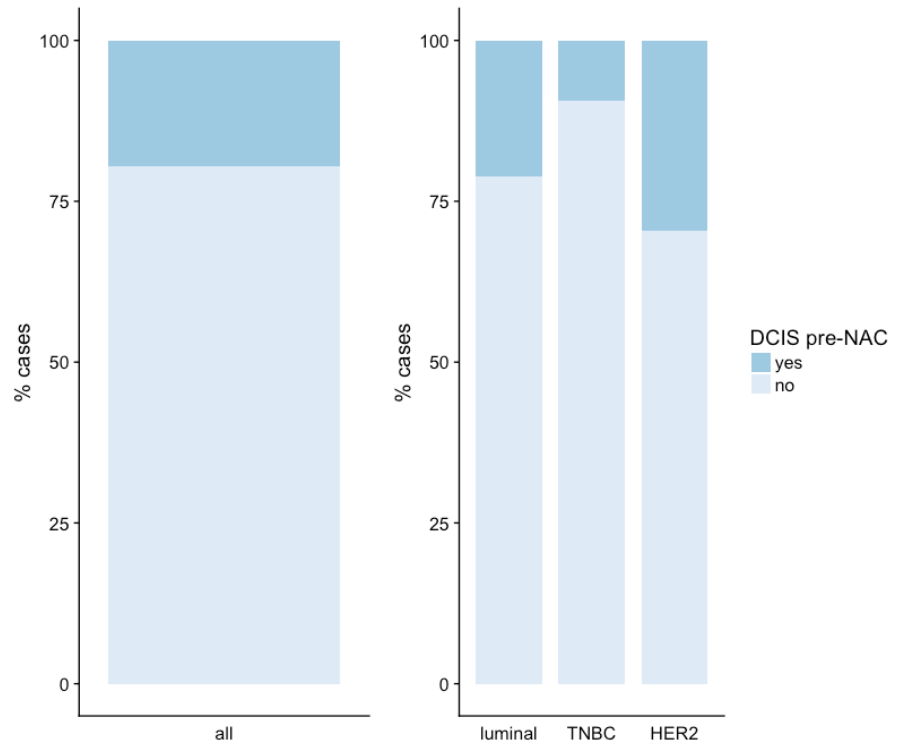
Figure 1. Presence of a ductal carcinoma in situ (DCIS) component on breast cancer biopsy before neoadjuvant chemotherapy (NAC). Abbreviations: ductal carcinoma in situ (DCIS), neoadjuvant chemotherapy (NAC)